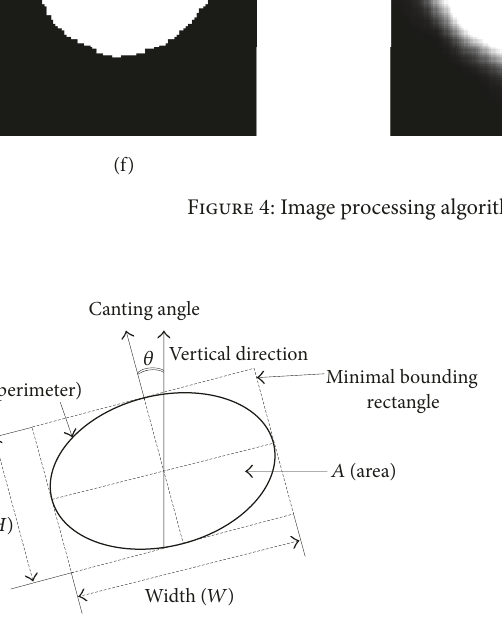
Figure 5: Minimal bounding rectangle of raindrop image.